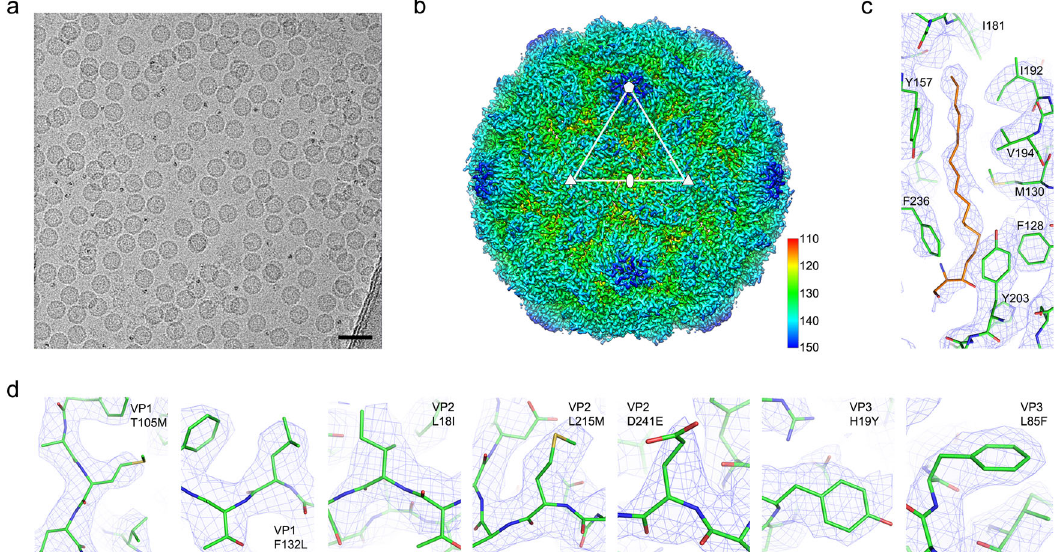
Fig. 8 Cryo-EM structure analysis of the stabilised PV3 SC8 VLP. a Cryo-electron micrograph of PV3 SC8 VLPs embedded in vitreous ice. Scale bar 50 nm. b Cryo-EM map of the PV3 SC8 reconstruction coloured by radius from red to blue according to the scale bar shown. Representative 5-fold, 3-fold and 2-fold axes are indicated. The outer diameter of the particle is ~300 Å. c Electron potential map for the PV3 SC8 VP1 pocket showing the bound sphingosine-like molecule (orange) and surrounding residues of VP1 (green); key residues interacting with the modelled sphingosine are labelled. Electron potential is contoured at 1.0 σ and rendered at a radius of 2 Å around atoms. d Individual panels showing the cryo-EM density for the stabilising mutations introduced into the PV3 SC8 VLP. Residue numbering is equivalent to the mature capsid proteins VP1, VP2 and VP3. VP4 T67A was disordered. Electron potential is contoured at 1.0 σ and rendered at a radius of 2 Å around